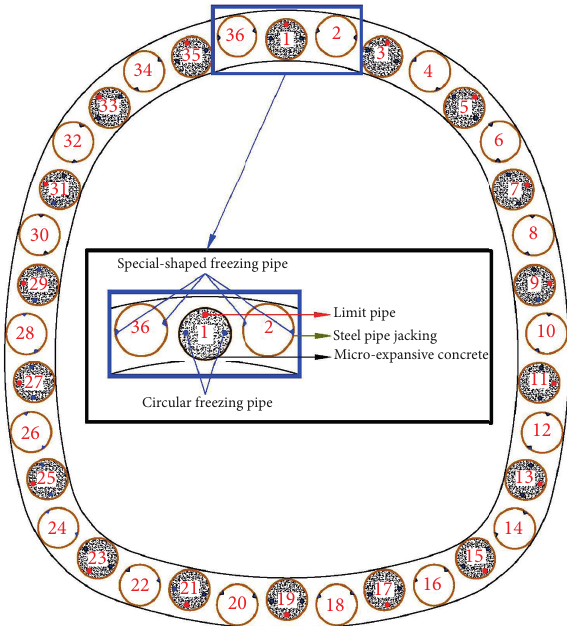
Figure 2: Layout of the pipe